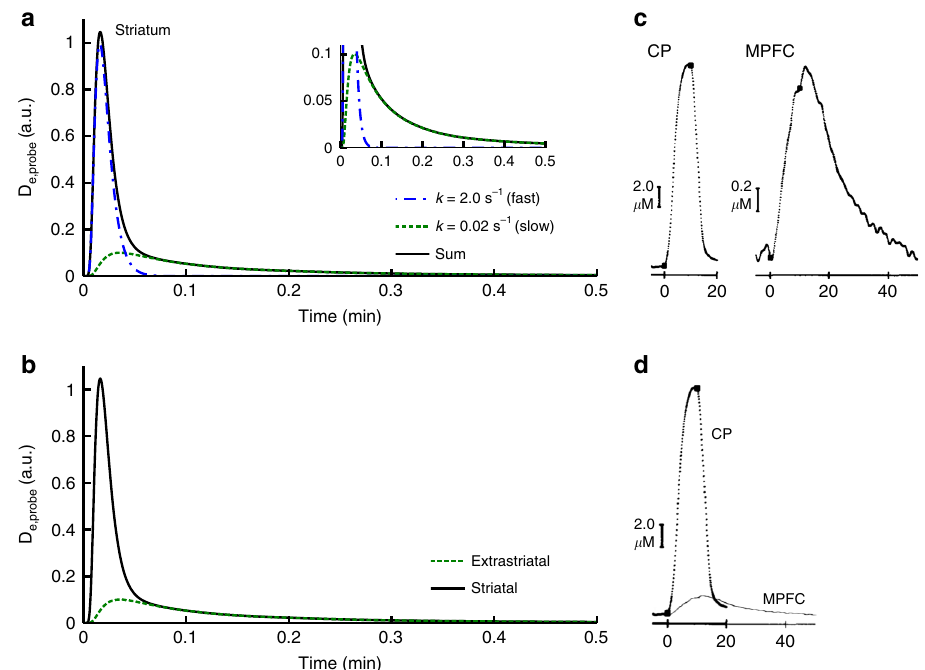
Fig. 2 Extracellular DA after synaptic release. a Calculated extracellular DA concentrations at the location of an FSCV electrode (black, solid) assuming that the signal contains contributions from a fast domain (blue, dash-dot) with high density of DA transporters (DATs) and a slow domain (green, dashed) with low density of DATs (Equation 1). DA is removed from the fast domain at a rate of s − 1 and from the slow domain at a rate of min − 1 . Although the overall FSCV signal in the striatum is dominated by the signal from the fast domain, the slow domain determines variations of extracellular DA concentration on a minute-by-minute scale. The amplitudes of both, the fast and the slow domain, depend on synaptic DA release. b The peak amplitude of dopamine transients in extrastriatal regions is lower due to the lower spatial density of DA synapses (green, dashed). All of the released DA is removed at minute time scale due to the lower density of DATs in extrastriatal regions in comparison to the striatum. Consequently the amplitude of minute-by-minute changes in extracellular DA concentration is the same in extrastriatal and striatal regions (black, solid). c Simultaneous FSCV recordings from the striatum (CP) and the medial prefrontal cortex (MPFC) in rats after electrical stimulation of the VTA by Garris et al. support this theory 42 . In order to evoke a detectable signal in the MPFC the VTA was stimulated at superphysiological amplitudes. d Combination of the CP and MPFC traces in a single graph indicates that the tail representing slowly removed DA in the CP is of the same magnitude as the extrastriatal